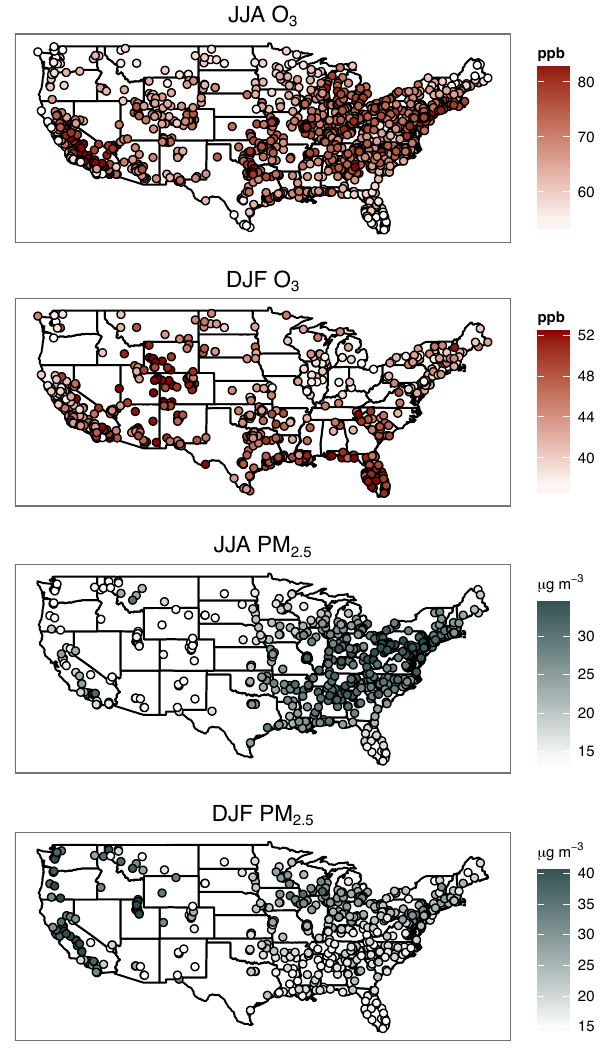
Figure 2. Location of AQS stations included in this study. The mag- nitude of each station’s 95th percentile measurement is indicated by